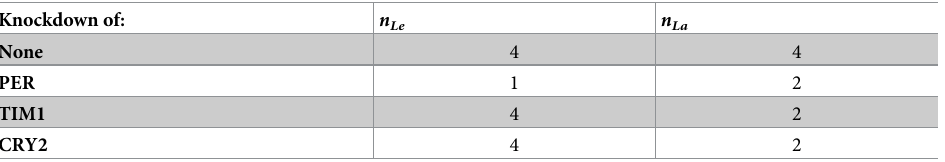
Table 3. Reduction of the number of oscillators as respective knockdown simulations.